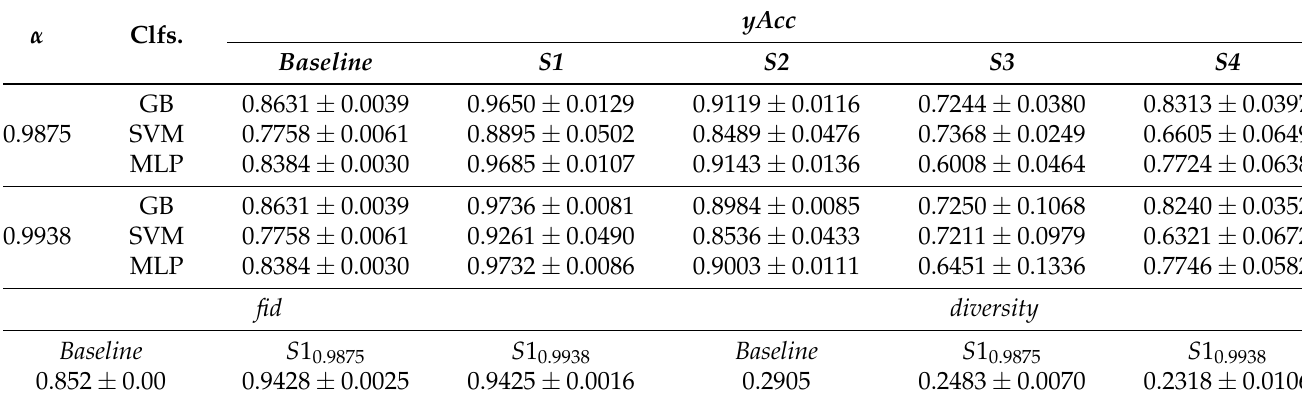
Table A3. Evaluation of GANSan ’s utility on adult Census.